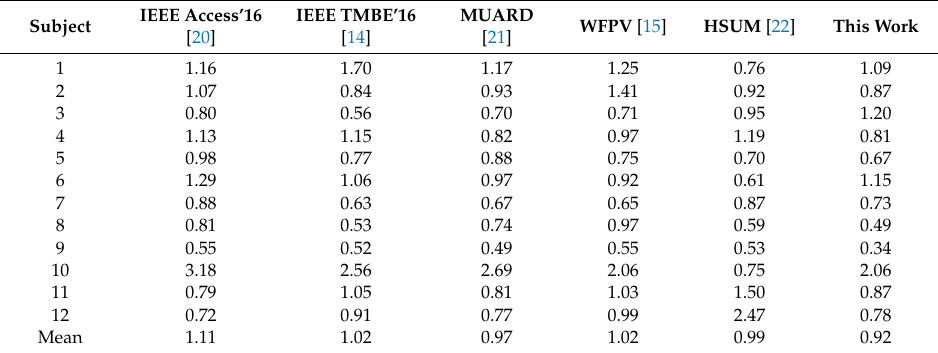
Table 4. Comparison of the results of HR AAE for the open source data set.